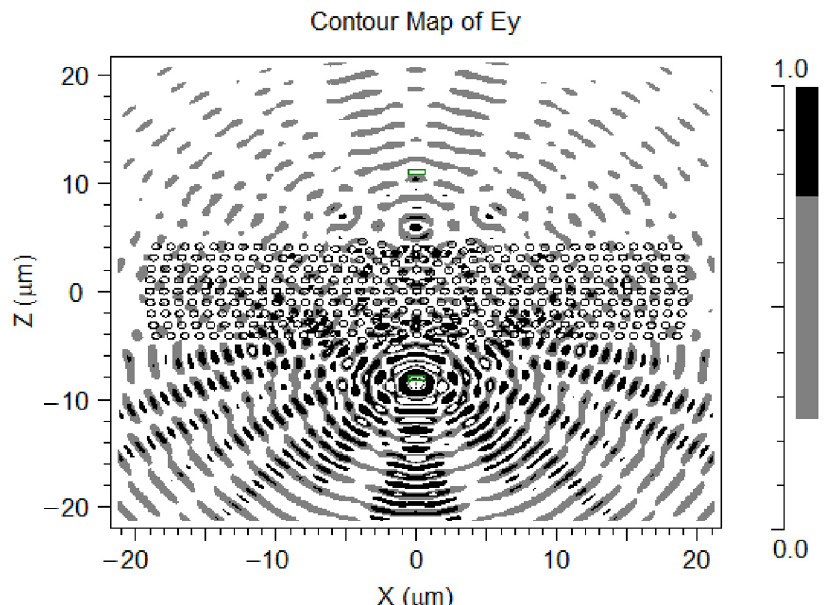
Figure 3. Intensity distribution of the 9-layer flat lens at refractive index 1.6 and wavelength 1.7 µm.